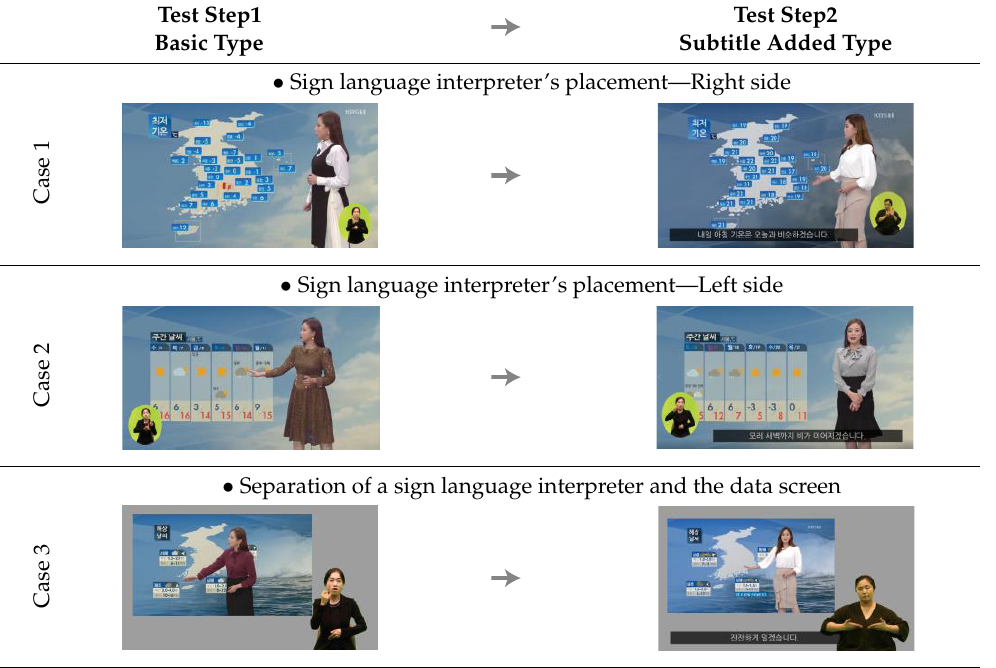
Table 2. Experiment design for news.